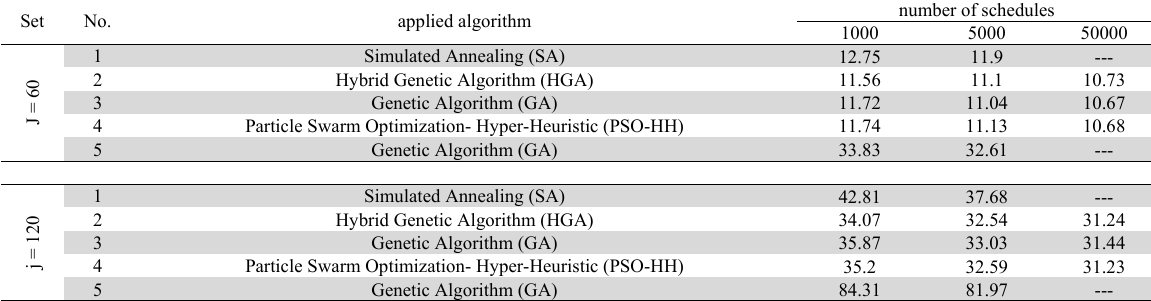
Average deviations from critical path lower